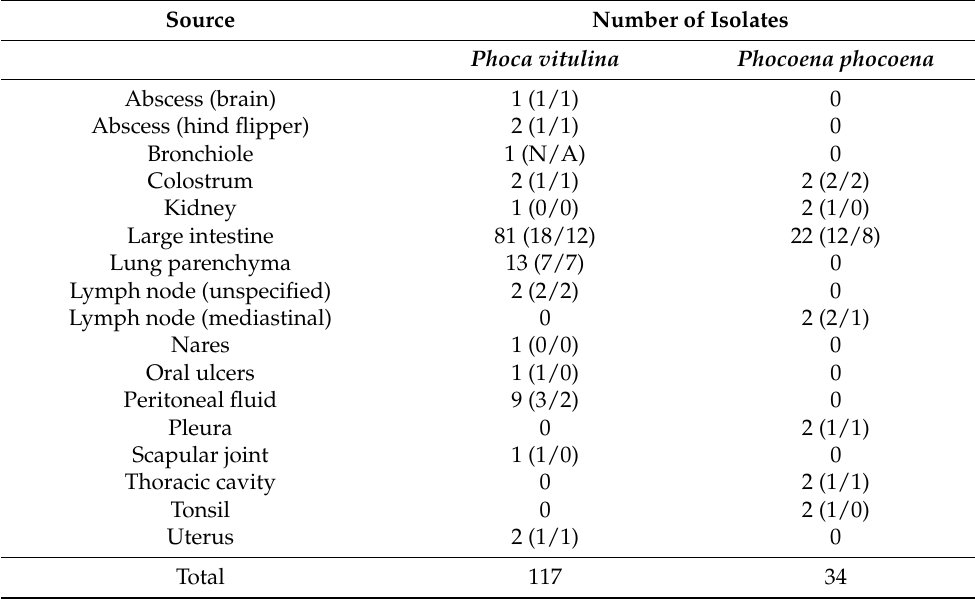
Table 2. Bacterial isolates by source and marine mammal species. Harbor seal = Phoca vitulina ; harbor porpoise = Phocoena phocoena . In the case where more than one bacterial species was identified, the number of isolates was greater than the number of swabs taken. Where applicable, the first number in parentheses refers to the number of isolates resistant to at least one antibiotic, followed by number of isolates resistant to more than one antibiotic. N/A = not tested for